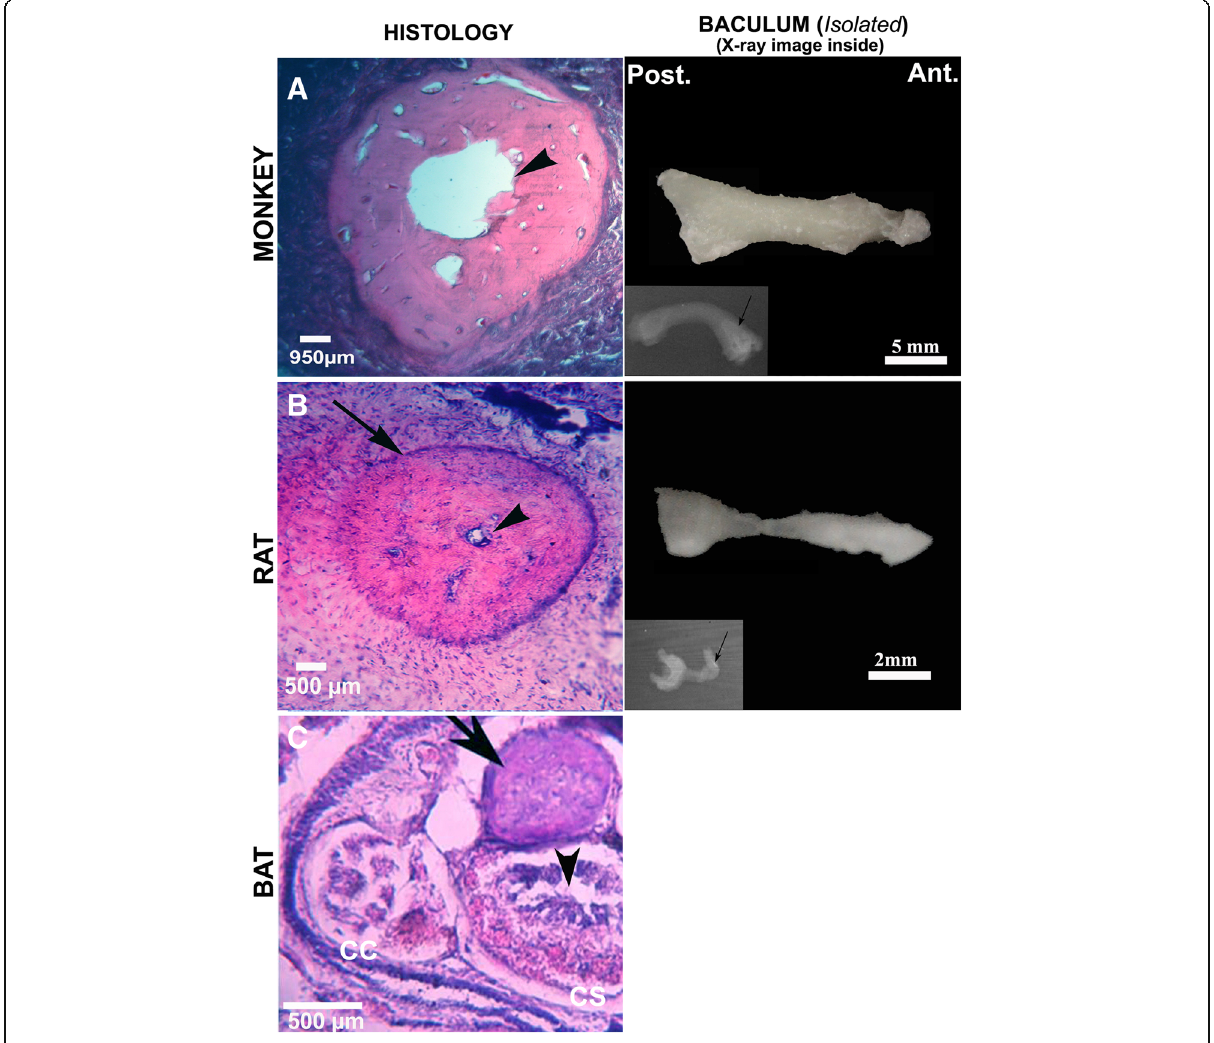
Fig. 1 Photomicrograph (H&E staining) of the penile transverse section taken from the monkey ( a ), rat ( b ), and bat ( c ). First column: In the monkey, the baculum appears like a miniature of a long bone, a clear central medullary cavity was seen (arrow head) and surrounded minor channels. Similar in rat baculum (arrow), a medullary canal (arrow head) is surrounded by smaller canals. The baculum in the bat (arrow) is seated over the corpus spongiosum (CS) with corpus cavernosum (CC) along its lateral aspect (bilaterally), arrowhead pointing urethral orifice in the corpus spongiosum. Small diameter channel in the bat is the main lamellar bone which appears as a single osteon or Haversian system). Second column: Dissected and isolated baculum from monkey and rat with corresponding radiological images placed inside (baculum — indicated by an